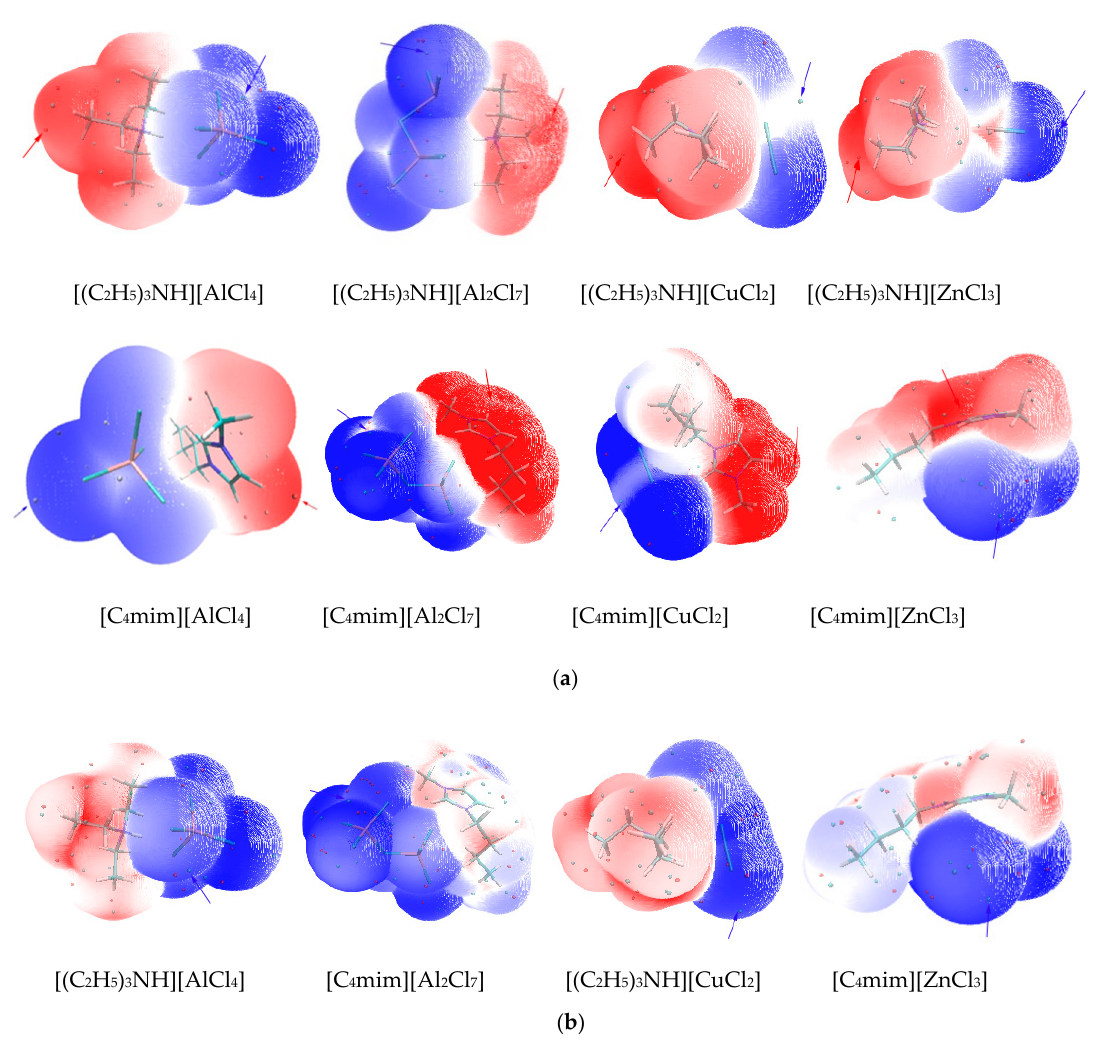
Figure 1. Molecular surface properties of chloroaluminate ILs: ( a ) the electrostatic potential with a 0.001 a.u. contour of the electron density and location of the V s,max (red arrow) and V s,min (blue arrow) on the ILs; ( b ) the average local ionization energy with a 0.001 a.u. contour of the electron density and 𝐼̅ s,min on the ILs (blue arrow).